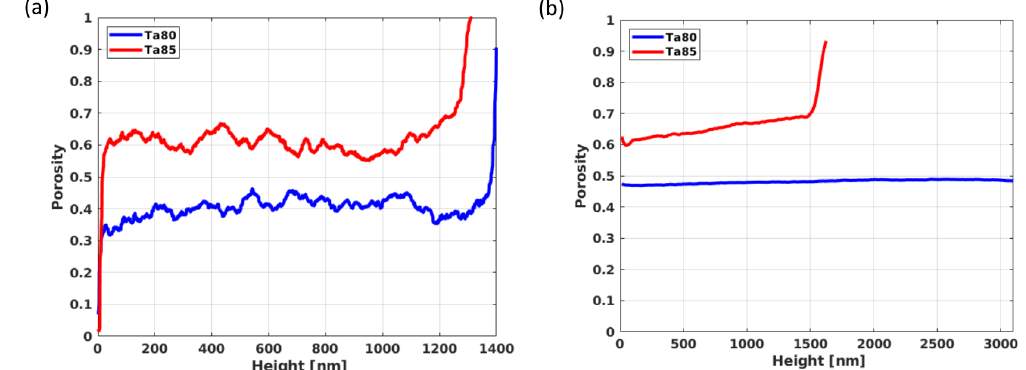
Figure 9. Porosities as functions of the height over the substrate: (a) Porosity in 1-D segments of the 2-D images from Fig. 8b and d. (b) Porosity in xz slices of the reconstructed FIB-SEM stacks. Porosity remains nearly constant for Ta80, whereas it increases with height for